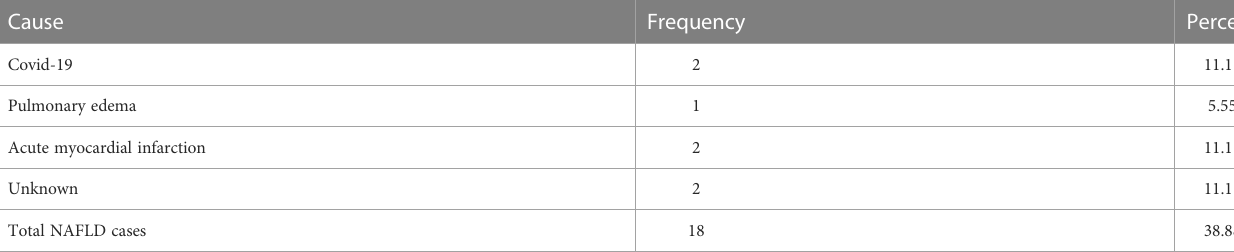
TABLE 2 Causes of death in NAFLD